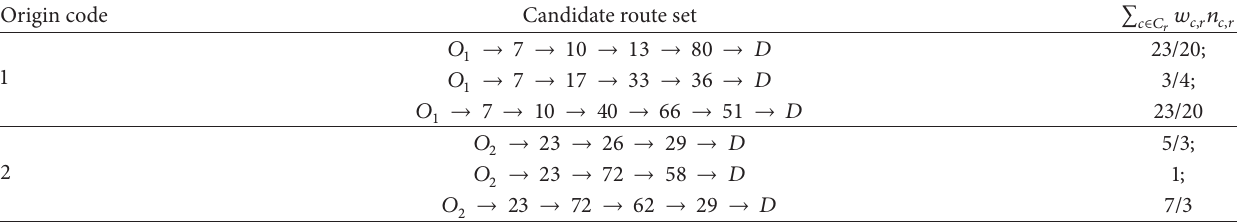
Table 2: Candidate route set and the commonality factor of each route.